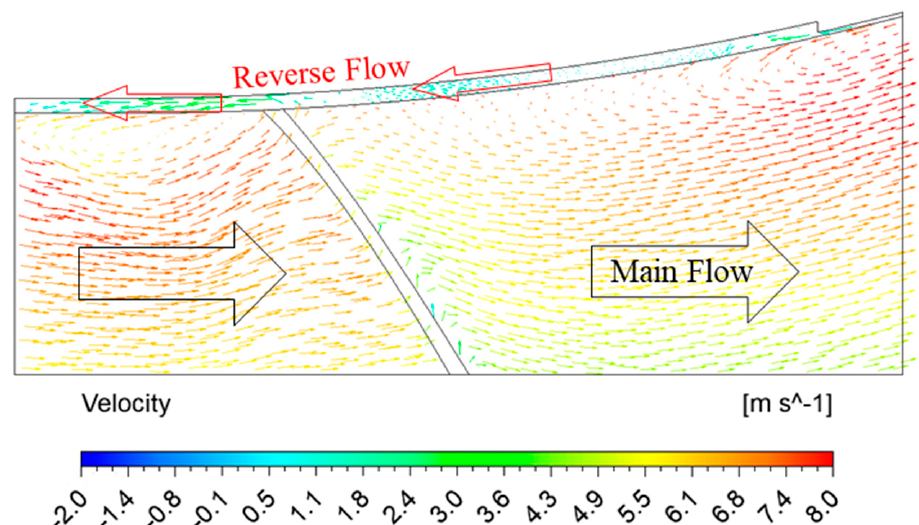
Figure 20. Velocity vector distribution in the SCP model with J-Groove at Q/Q BEP = 1.00.